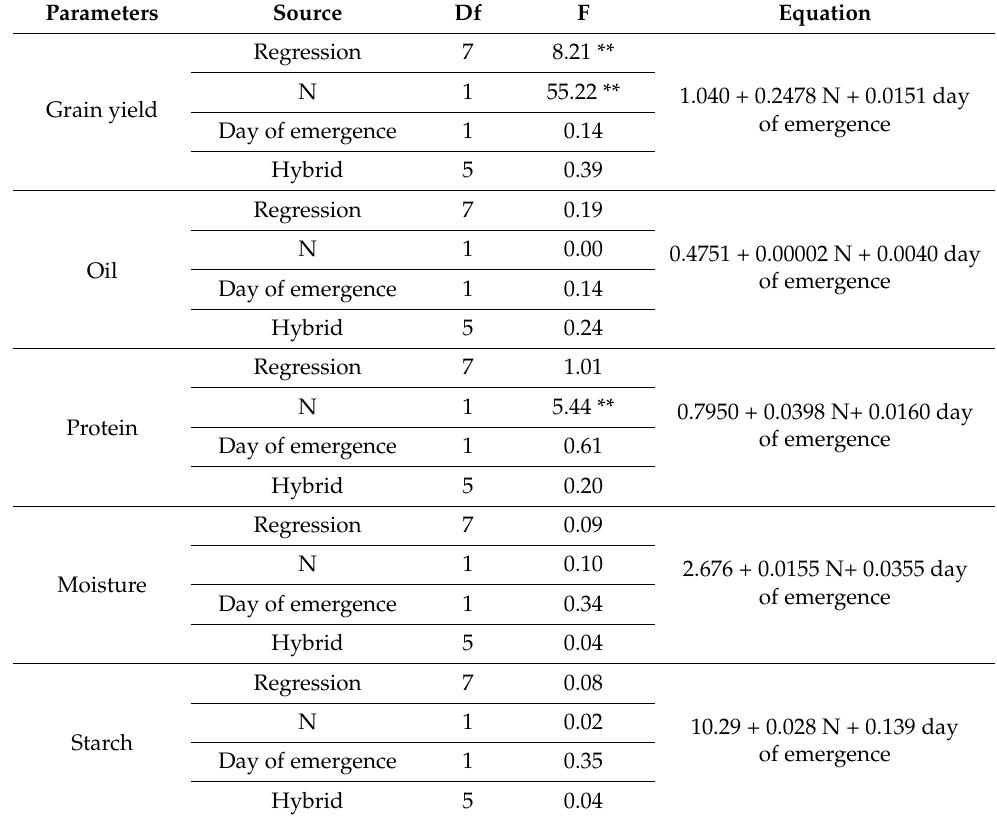
Table 4. Regression analysis of productivity